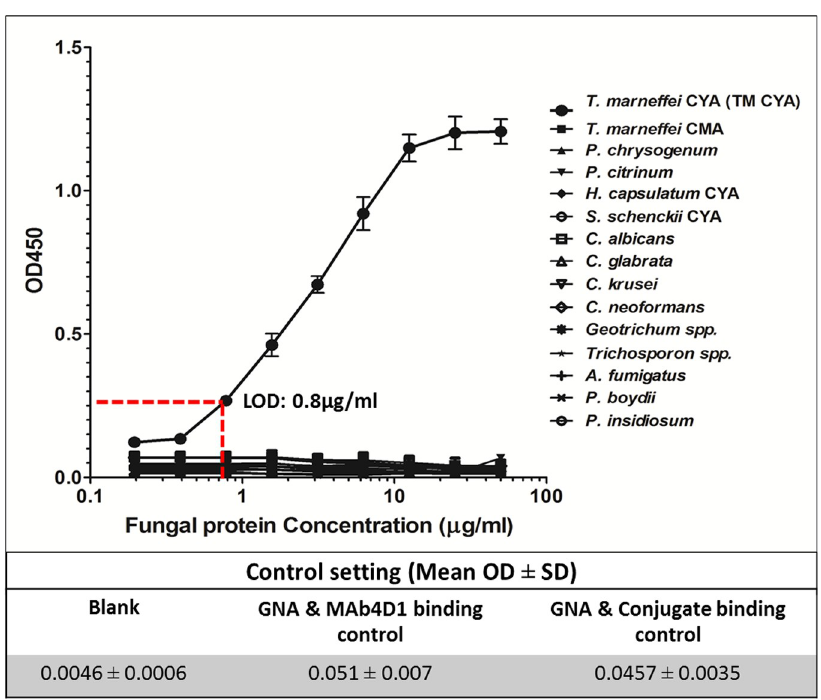
Fig 4. The specificity of the GNA–MAb 4D1 sandwich ELISA in the detection of TM CYA. TM CYA and TM CMA together with 13 other fungal antigen was tested in the ELISA. The positive reaction was indicated by the absorbance measured at OD 450 nm. The fungal protein concentrations were shown in log 10 scale. The results were shown as mean OD ± SD of three independent determinations. Abbreviation: CYA, Cytoplasmic Yeast Antigen; CMA, Cytoplasmic Mycelium